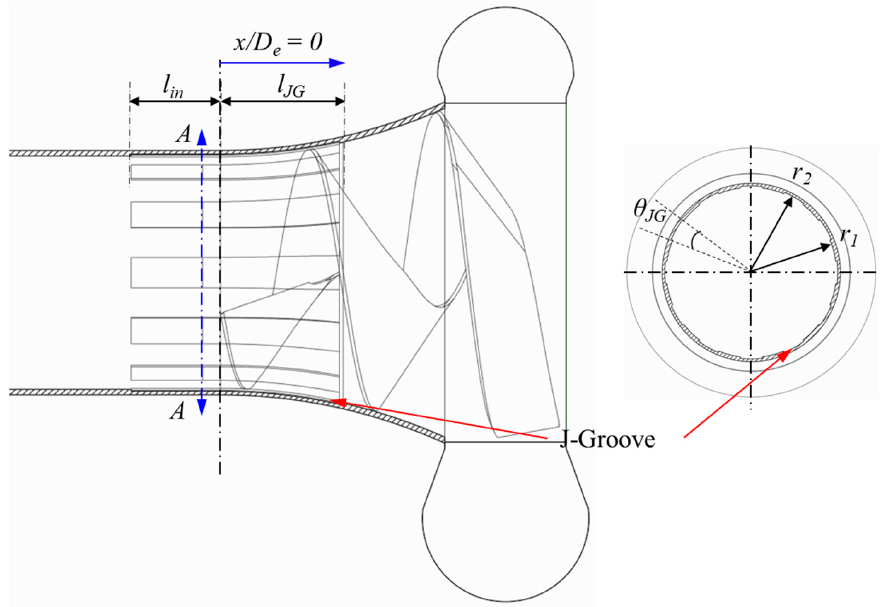
Figure 5. Schematic view of J-Groove shape parameters in screw centrifugal pump model. Table 3. Shape parameters of J-Groove for AJP and SCP models.